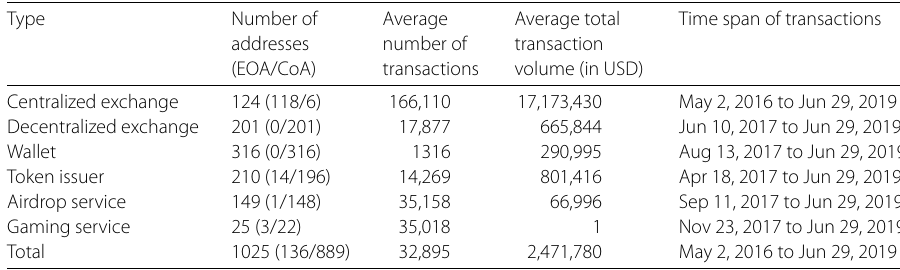
Table 1 Six key agent roles and their basic transaction statistics